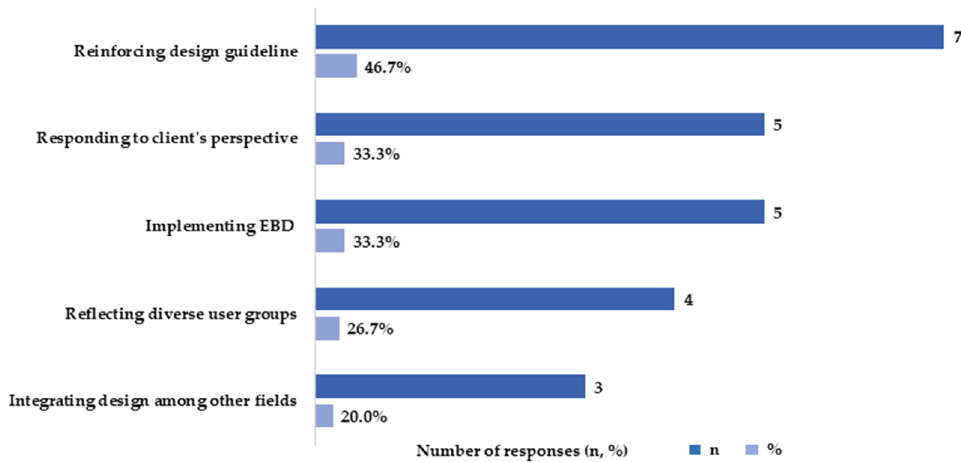
Figure 3. Hurdles and suggestions in healthcare design practice.